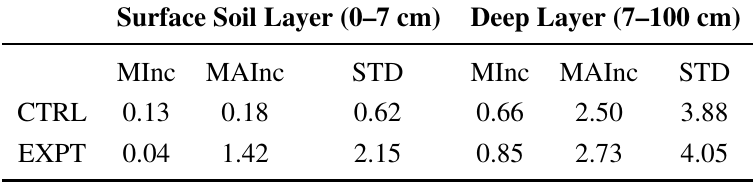
Table 2. Total soil moisture increments (MInc) and their absolute values (MAInc) and standard deviation (STD), averaged at global scale, for CTRL and EXPT experiments. All values are in mm